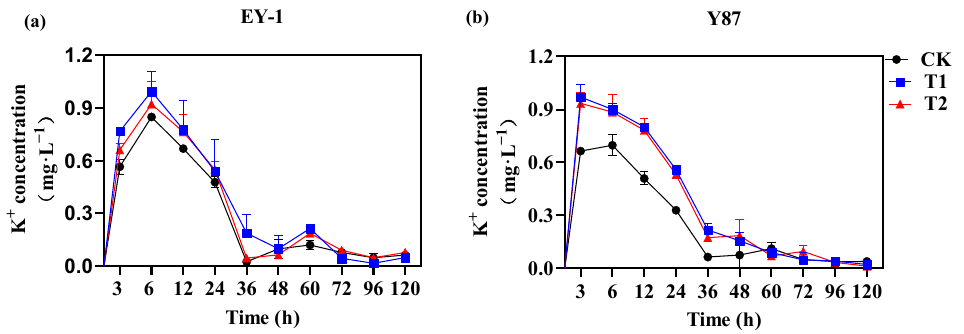
Figure 3. K + concentration in starvation solution for EY-1 ( a ) and Y87 ( b ). CK, control; T1, topping; T2, IAA application after topping.